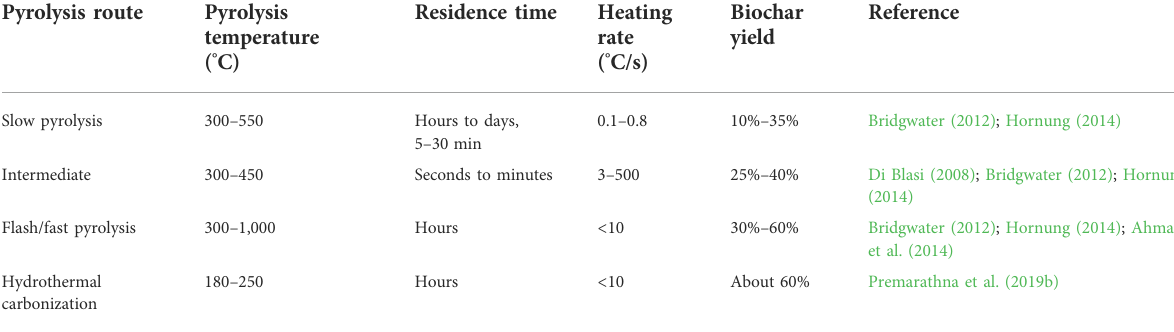
TABLE 1 Details of various pyrolysis mechanism conditions and product